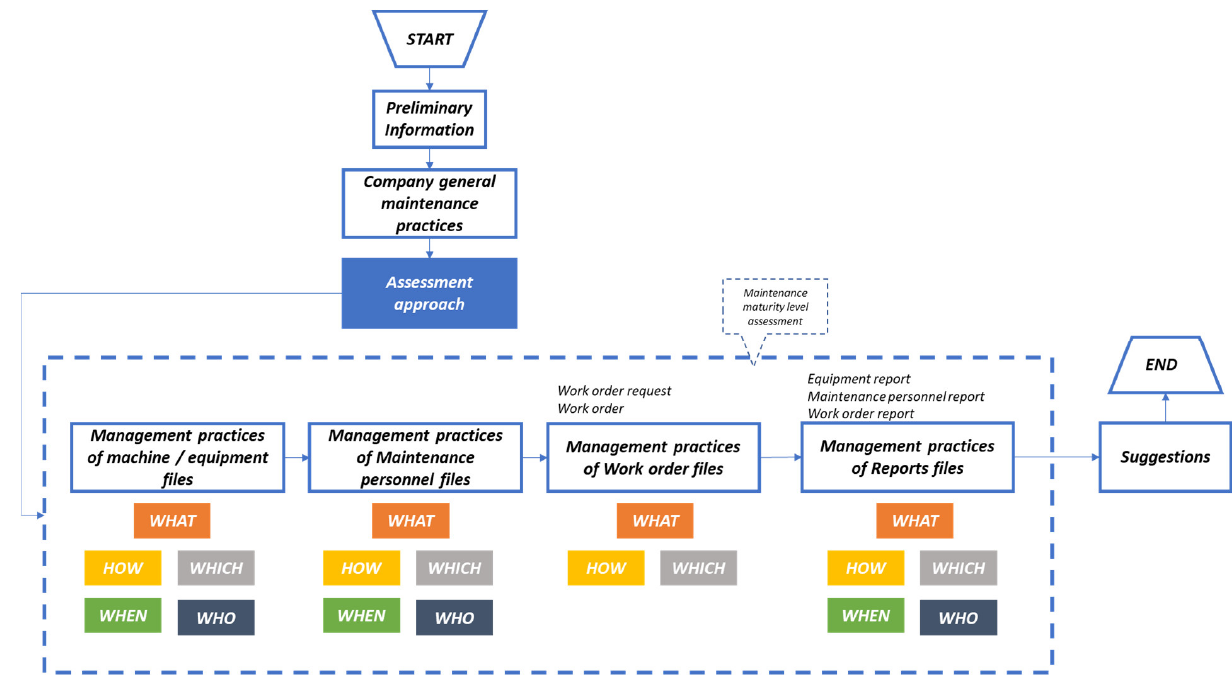
Figure 5. Survey Structure.